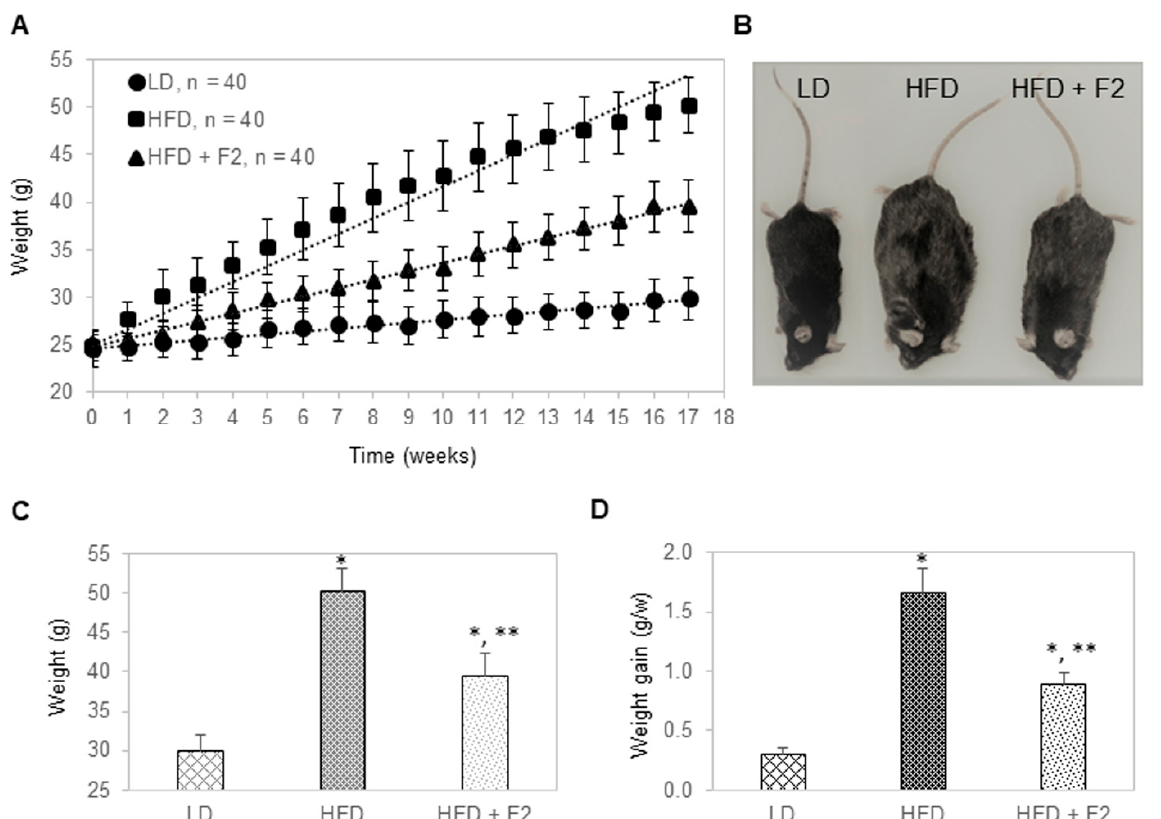
Figure 5. F2 composition reduces weight gain in diet-induced obesity mice. ( A ) Average body weight as a function of time on specified diets of three groups of mice: Lean diet, high-fat diet, and high-fat diet supplemented with F2. ( B ) A representative photo of mice from each diet group in week 17. ( C ) Average body weight in week 17 as a function of mice group on specified diets. LD: Lean diet; HFD: High-fat diet; HFD + F2: High-fat diet supplemented with F2. ( D ) Average rate of weight gain in grams per week (g/w) as a function of mice group on specified diets. The error bars indicate the standard deviations of 40 mice per animal group. Single asterisk (*) indicates a statistical significance of p -value ≤ 0.01 versus the lean diet group. Double asterisk (**) indicates a statistical significance of p -value ≤ 0.01 versus the high-fat diet group.